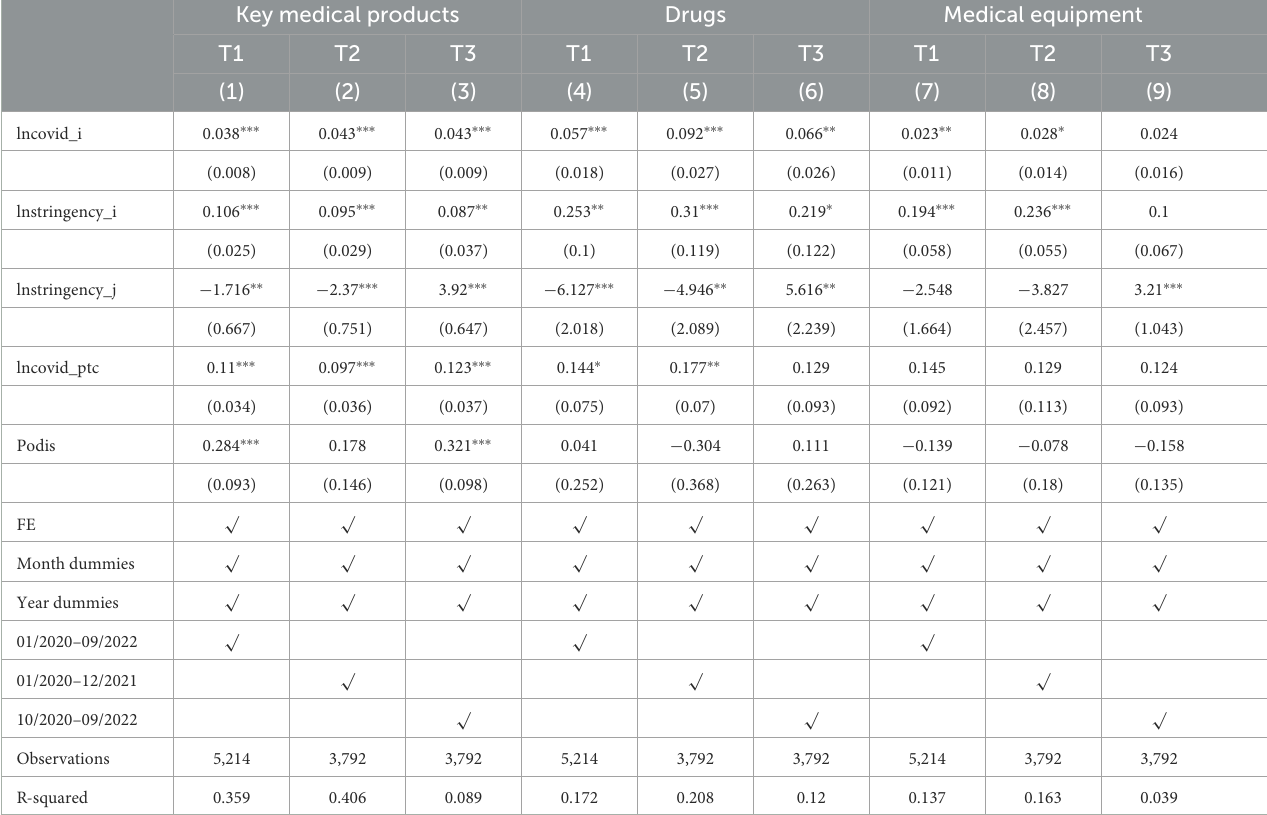
TABLE 4 Political distance regressions. Key medical